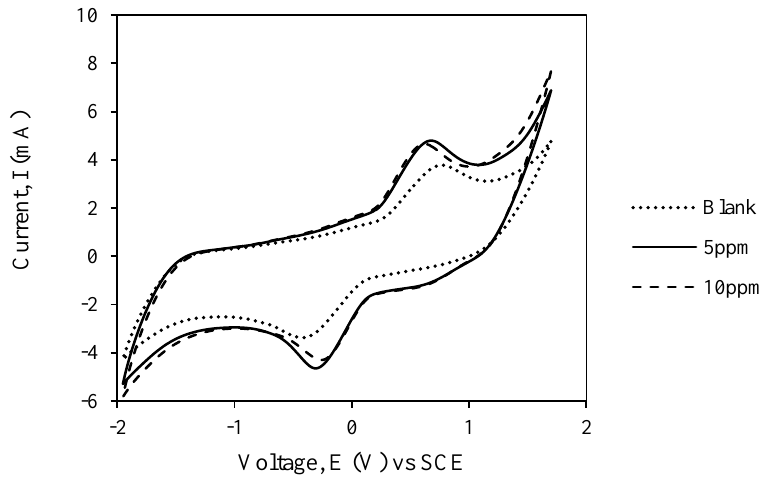
Figure 8. Cyclic voltammograms of the bare electrode in potassium ferrocyanide solution containing an increasing concentration of atrazine. The scan rate was 40 mV s − 1 .